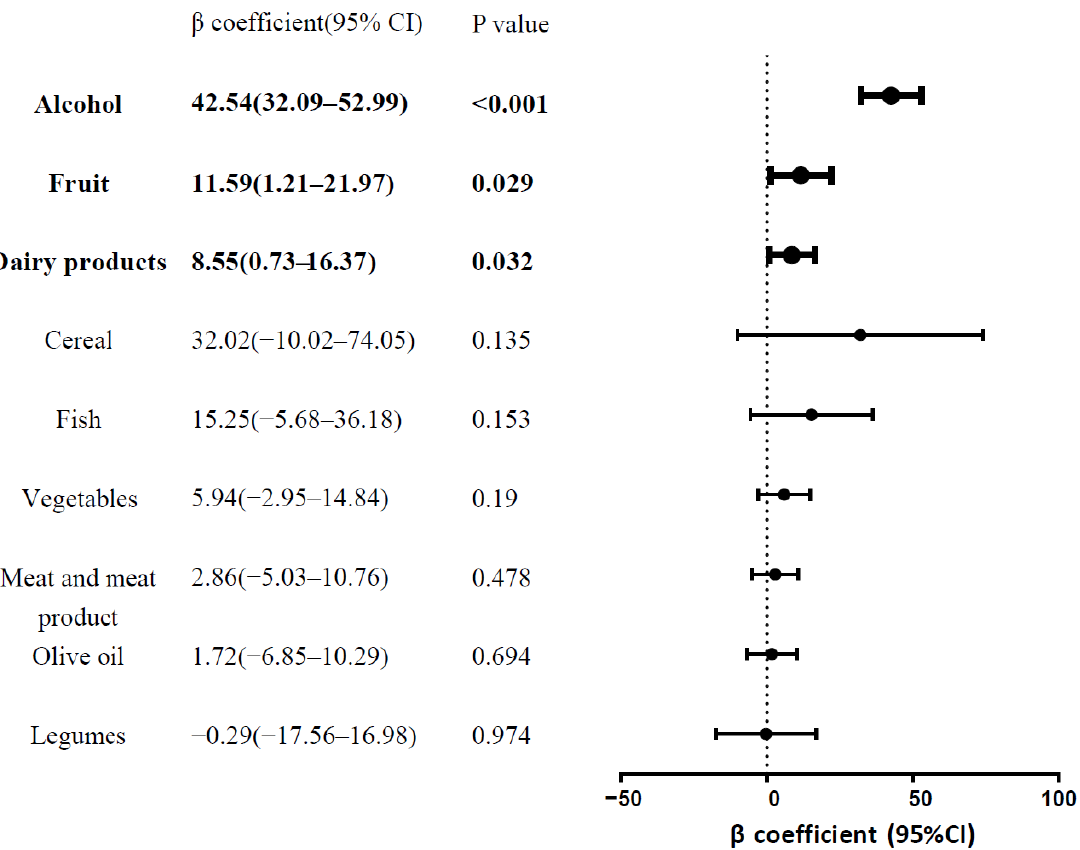
Figure 2. A line chart showing the change of mean s-Klotho levels in Mediterranean diet adherence score from the lowest (score ≤ 1) to the highest (score ≥ 12).